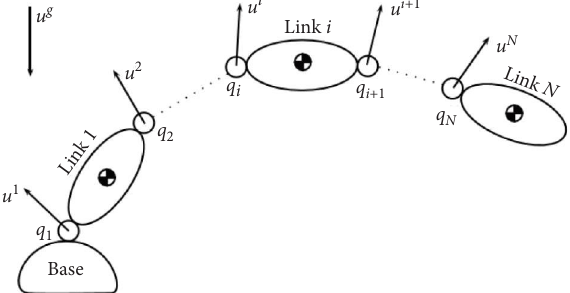
Figure 1: General scheme of the considered serial manipulator [15].